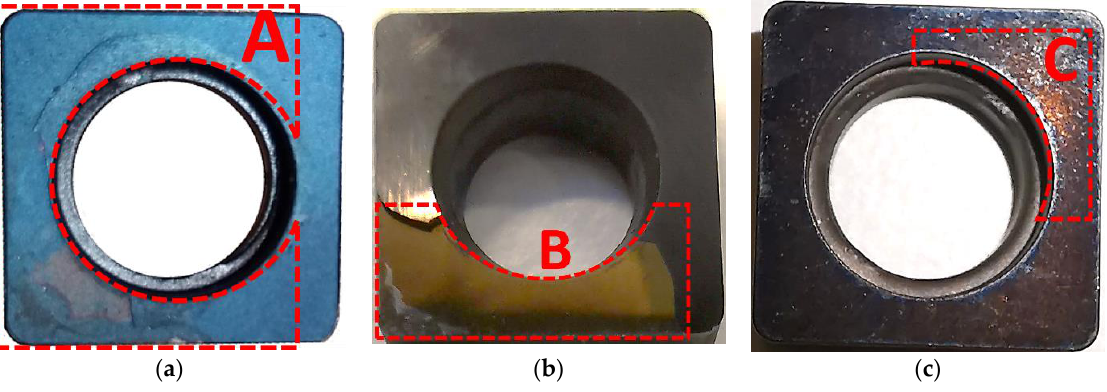
Figure 7. Cu:CuCN x coating on ( a ) DP shim, ( b ) M shim, and ( c ) GB shim after heating to 300 °C then gradually cooling to ambient temperature.